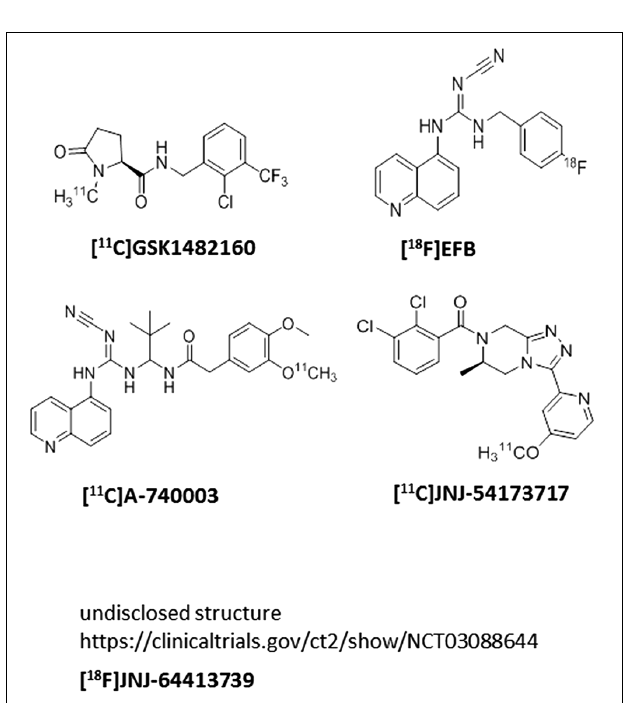
FIGURE 3 | P2X7 PET